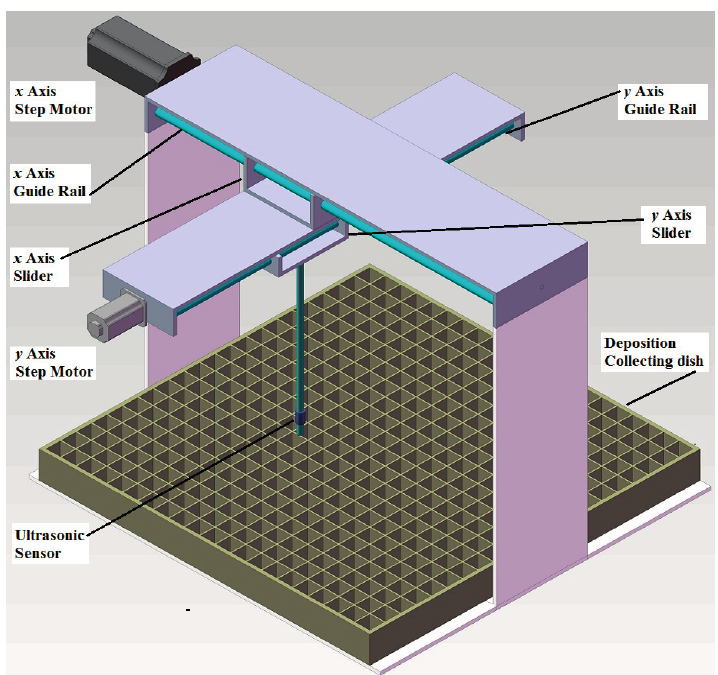
Figure 1. Structural diagram of the two-dimensional liquid-level measurement system